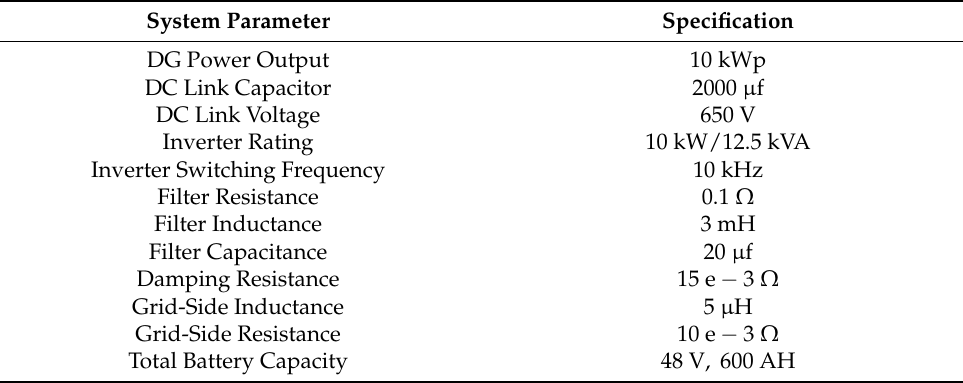
Table 2. Parameters of the three-phase grid-connected